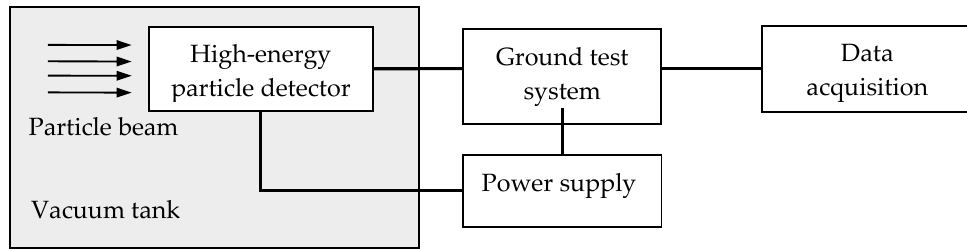
Figure 14. Experimental scheme of energy channel calibration.